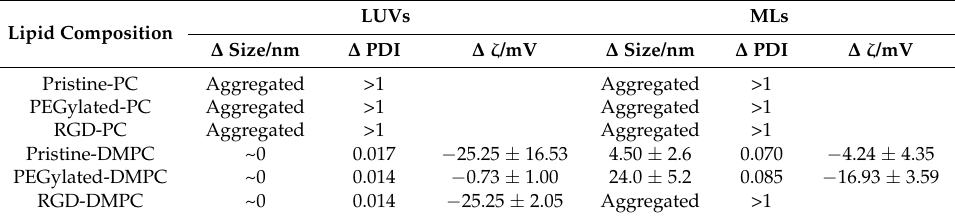
Table 2. Changes in size, polydispersity index (PDI) and ζ potential of LUVs or MLs upon incubation with 1 mg · mL − 1 (ca. 16 µ M) BSA for 24 h. The values are expressed as increases calculated by subtracting the initial value to the value after incubation. Pristine-PC or DMPC: PC/CHOL (8:2) or DMPC/CHOL (8:2); PEGylated PC or DMPC: PC/HOL/PEG (8:2:0.3) or